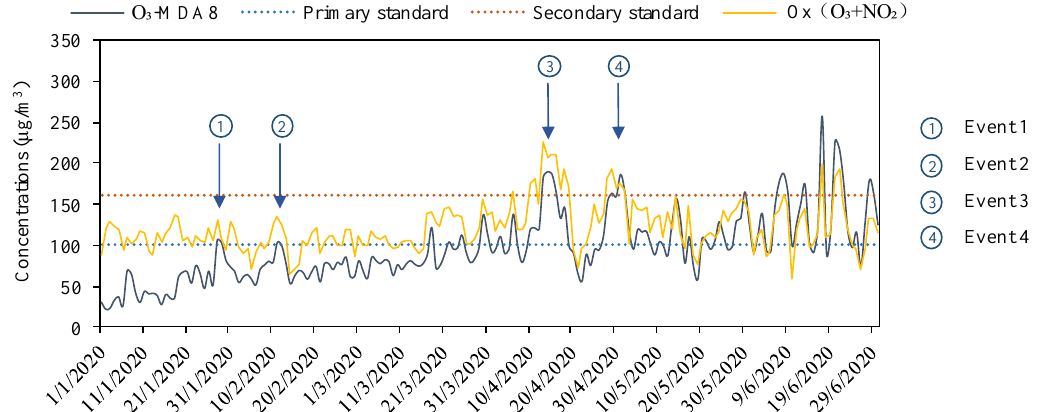
Figure 2. Diurnal variation of O 3 maximum 8-h moving average (MDA8) and Ox with event tagging